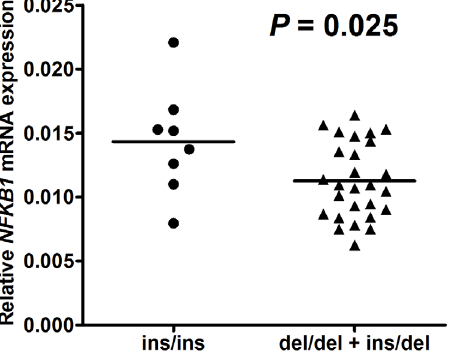
Figure 1. Analysis of NFKB1 mRNA expression in different genotypes of bladder cancer tissue with mean values (hori- zontal lines, mean values).